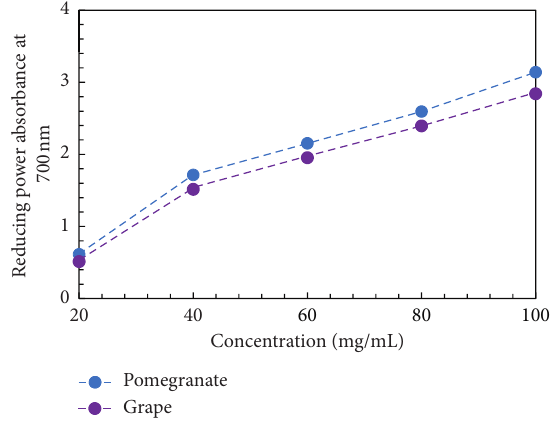
Figure 6: Reducing power of the aqueous grape pomace and pomegranate peel extracts was evaluated by the FRAP assay.